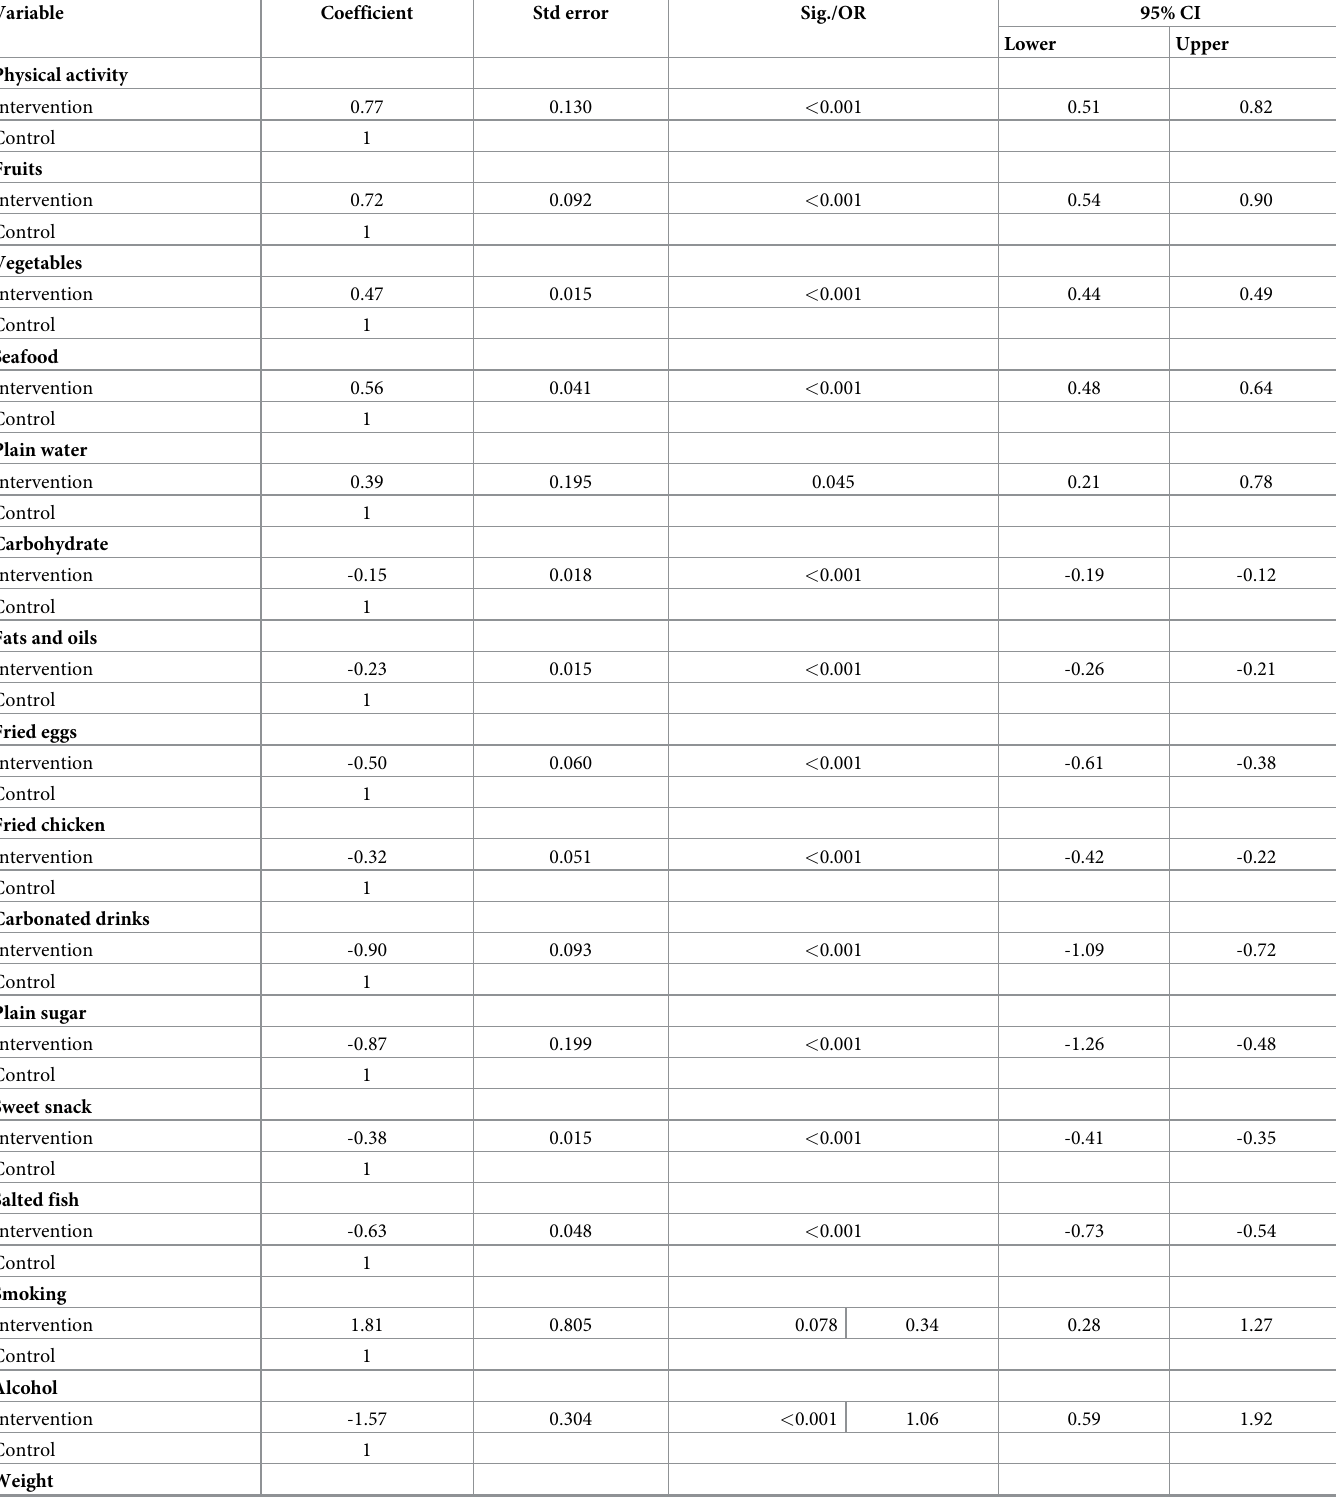
Table 6. Fixed coefficient of outcome